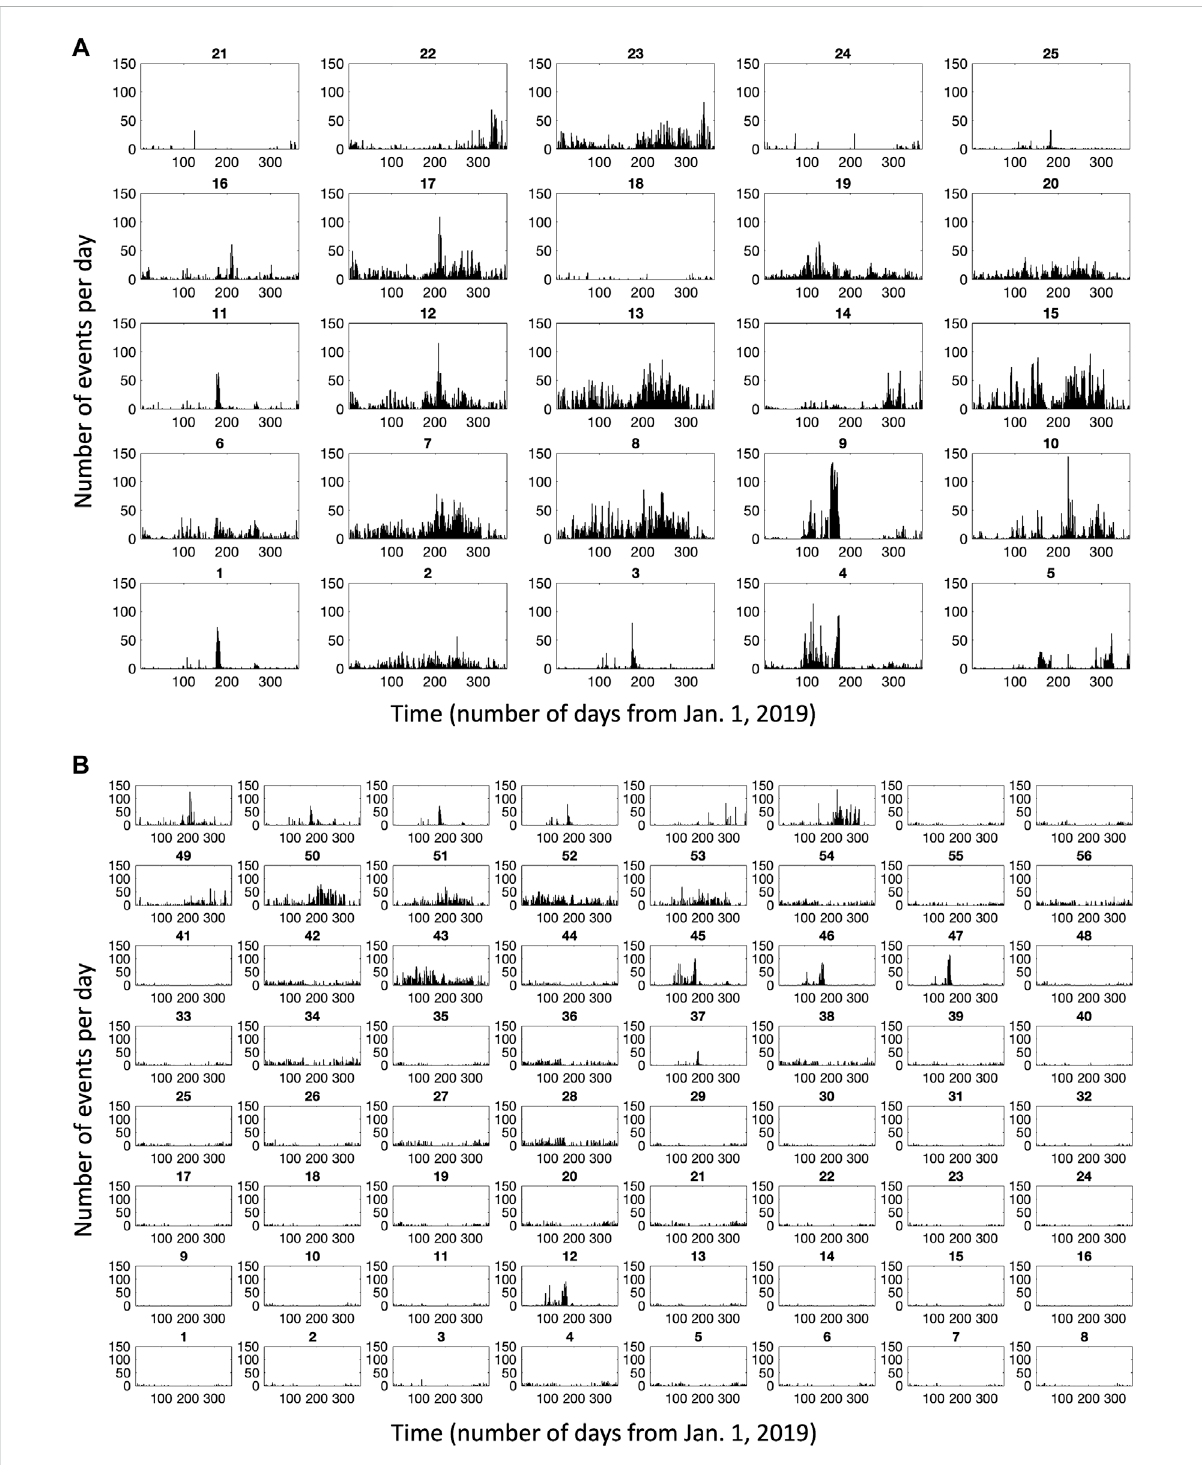
FIGURE 7 Temporal histograms of cumulative number of events per day belonging to the i th node determined by the SOM algorithm (A) events found by the VLP iteration (B) events found by the ULP iteration. The horizontal axis of the histograms indicates the time in 2019 Julian day. Signals falling in somenodesnotablyshow ahighclustering intime ofoccurrence. SinceSOM organizes data inthemaponly onthebasis ofshapesimilarity, thelow dispersion in the temporal distribution indicates a correlation between time occurrence (histogram) and shape of events.